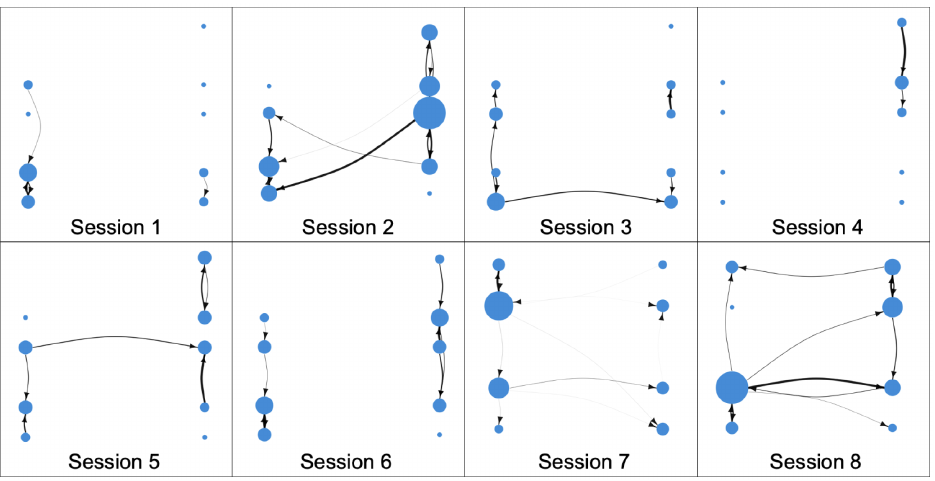
FIG. 12. Network diagrams for all coded sessions of section 2.